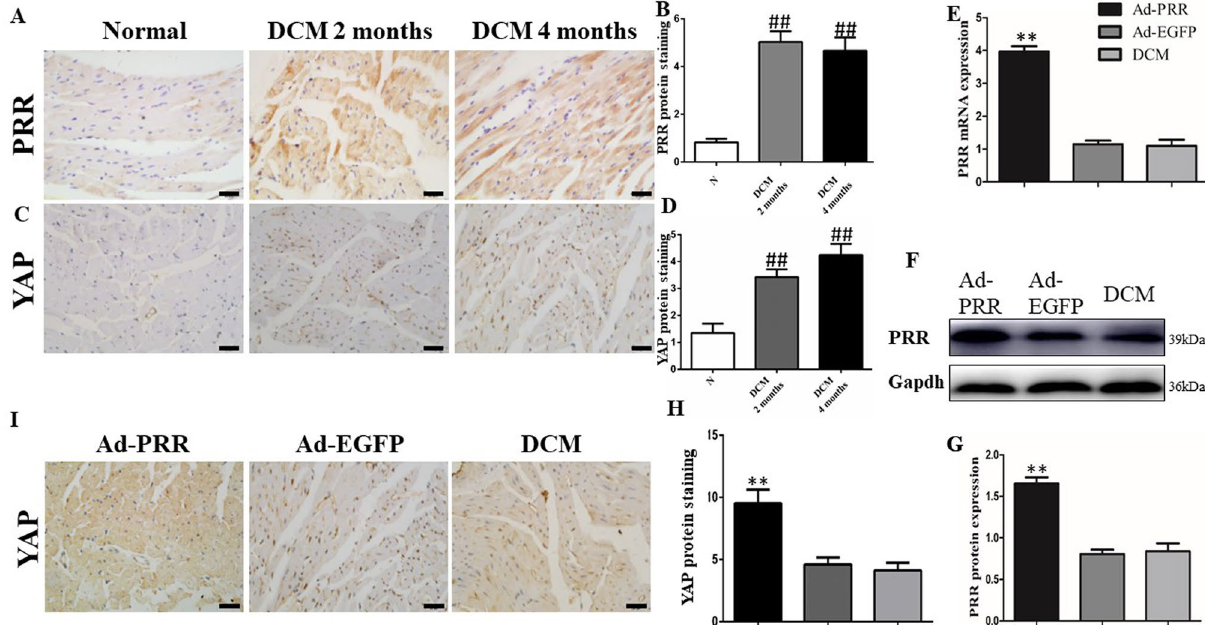
Figure 1. (Pro)renin receptor and YAP expression in rats. ( A ) Representative immunostaining of PRR protein expression 2 weeks and 4 weeks after STZ intraperitoneal injection. ( B ) Quantitative analysis of the results shown in ( A ). ( C ) Representative immunostaining of YAP protein expression 2 weeks and 4 weeks after STZ intraperitoneal injection. The results are calculated by counting positive expression area intensity and